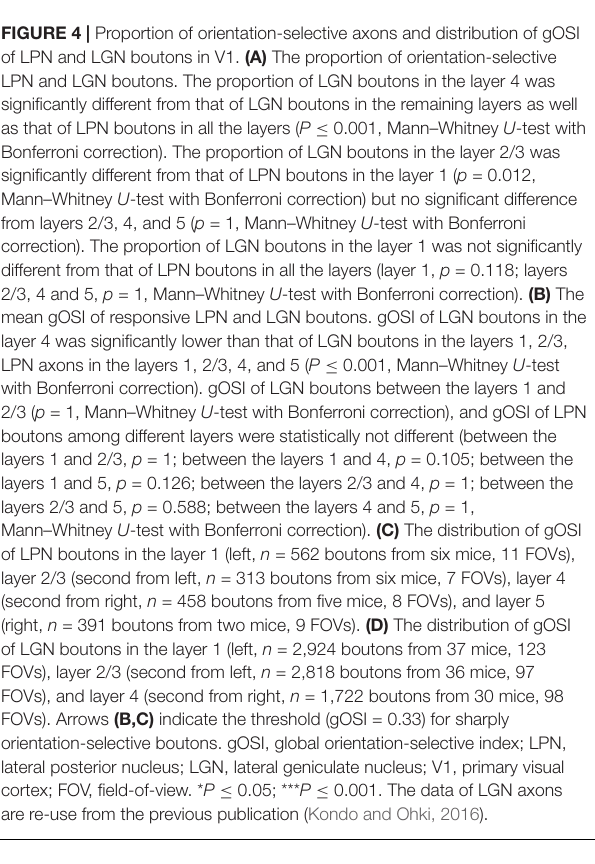
FIGURE 5 | Distribution of preferred orientations of LPN and LGN boutons in V1. The distribution of preferred orientations of LPN boutons (A) and LGN boutons (B) in each layer of V1. LPN boutons showed skewed bias from horizontal to vertical orientation, whereas LGN boutons showed cardinal bias. LPN, lateral posterior nucleus; LGN, lateral geniculate nucleus; and V1, primary visual cortex. The data of LGN axons are re-use from the previous publication (Kondo and Ohki,